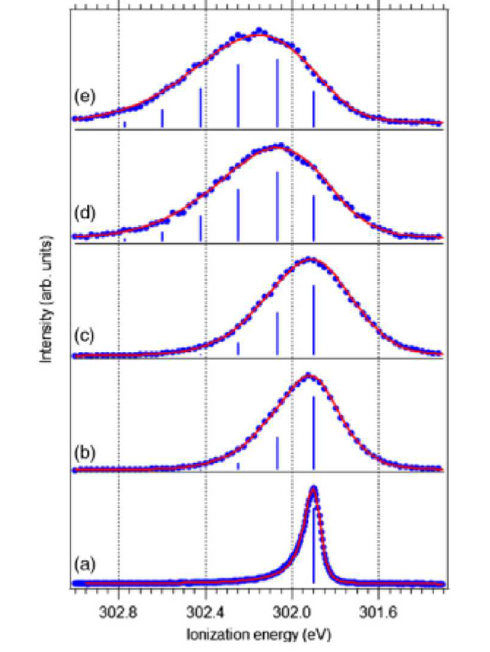
4 molecule measured at different photon energies. Fig. 3. Vibrational recoil of the C1s core-ionized CF